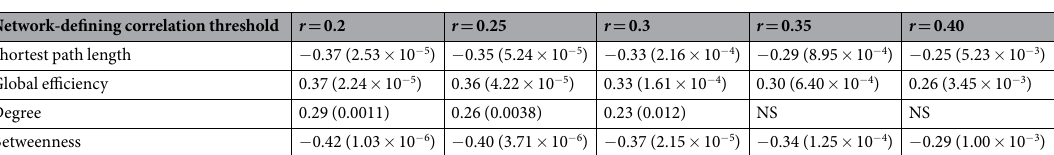
Table 3. Partial correlation values between different network measures and age after adjusting for sex and ACE-R total score. Network measures were estimated using different values of network-defining connectivity threshold r . NS – no significant correlation was observed after correcting for multiple comparisons using FDR q < 0.05. ( * ) p -values.